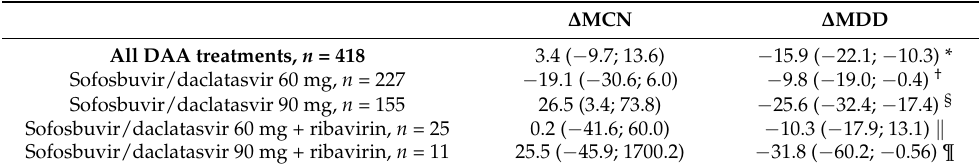
Table 2. MtDNA parameter variation after DAA treatments ((ETT—Baseline/Baseline)*100) in %, median (95% CI).